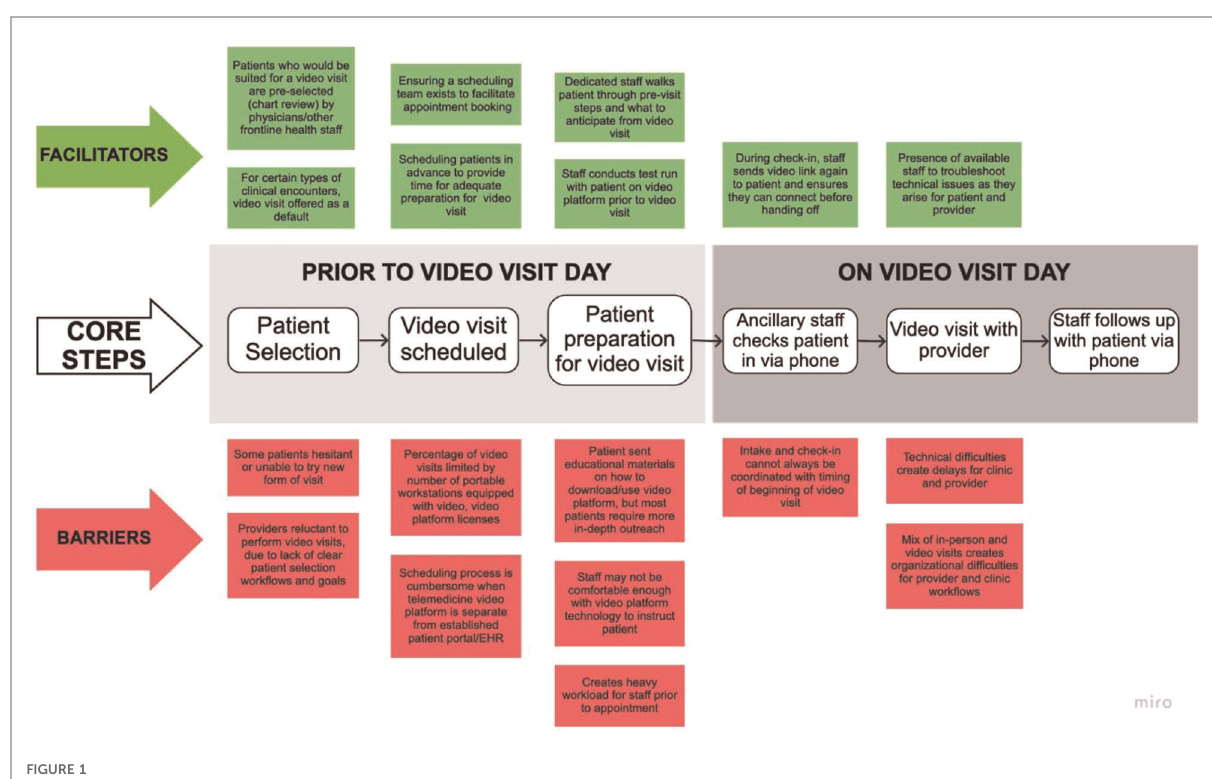
FIGURE 1 Process map for typical LAC DHS clinic video